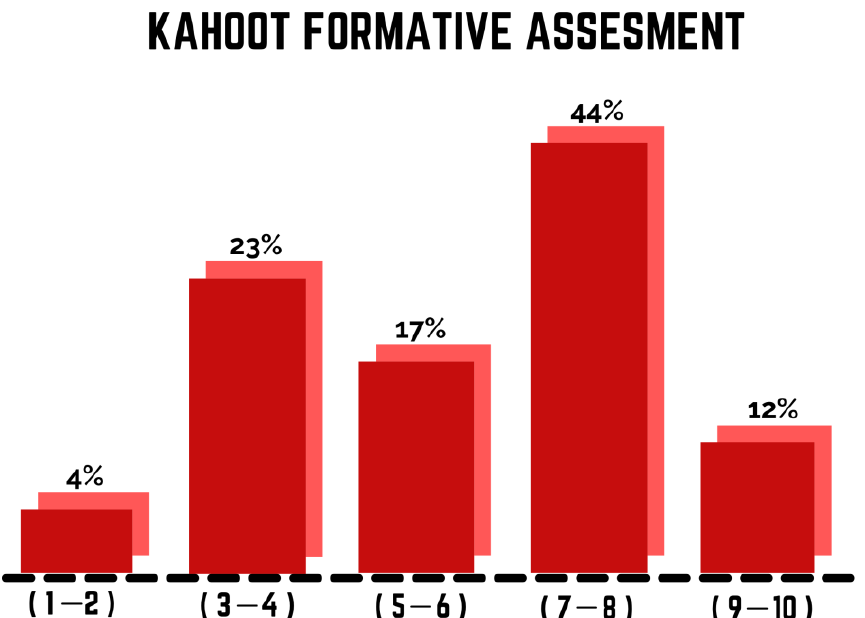
Figure 6. Table with the results obtained by the students in the formative evaluation activity inte- grated by the application of a 10-question questionnaire in Kahoot, in which the correct identification of the terms and etymological particles of the area of philosophy was verified.